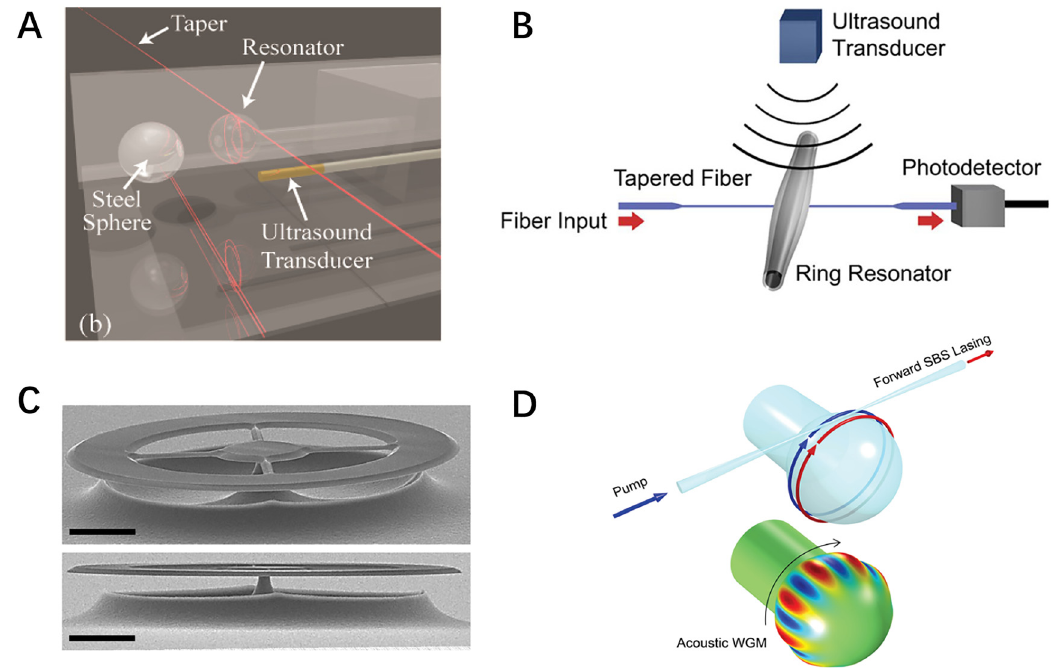
Figure 20: Acoustic sensing using different cavity optomechanical systems: (A) silica microsphere cavity [55], (B) silica microbottle cavity [56], (C) silica microdisk cavity [57], and (D) stimulated Brillioun lasing in silica microspheres